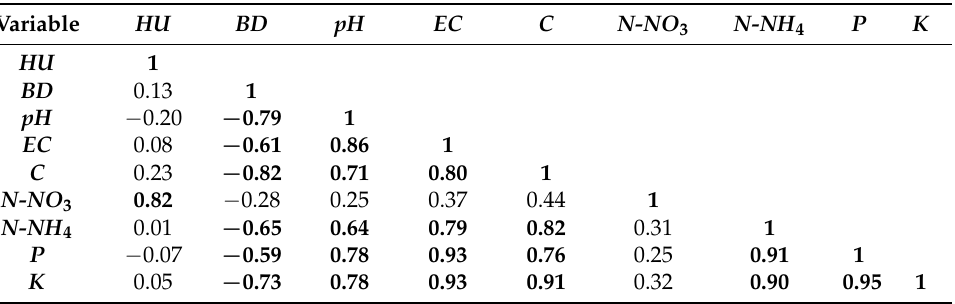
Figure 2. Projections of variables ( HU , BD , pH , EC , C , N-NO 3 , N-NH 4 , P , and K ) and samples (S1, S2, S3, S1 + BC, S2 + BC, and S3 + BC) on the factor-plane PC1–PC2; ( HU ) humidity; ( BD ) bulk density; ( EC ) electrical conductivity; ( C ) total carbon concentration; ( N-NO 3 ) soluble nitrate nitrogen concentration; ( N-NH 4 ) soluble ammonium nitrogen concentration; ( P ) soluble phosphorus concentration; ( K ) soluble potassium concentration; (BC) biochar; (S1) fluvisol soil; (S2) chernozem soil; (S3) luvisol soil. Table 5. Correlation Table 4. Factor loadings.